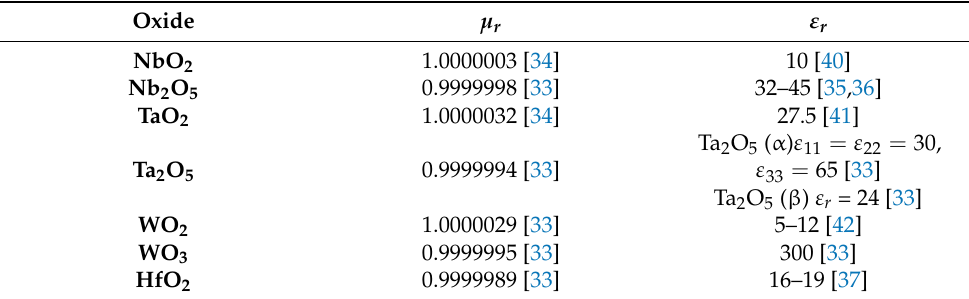
Table 1. Magnetic and dielectric constant of tantala, niobia, hafnia, tungsta. Oxide µ